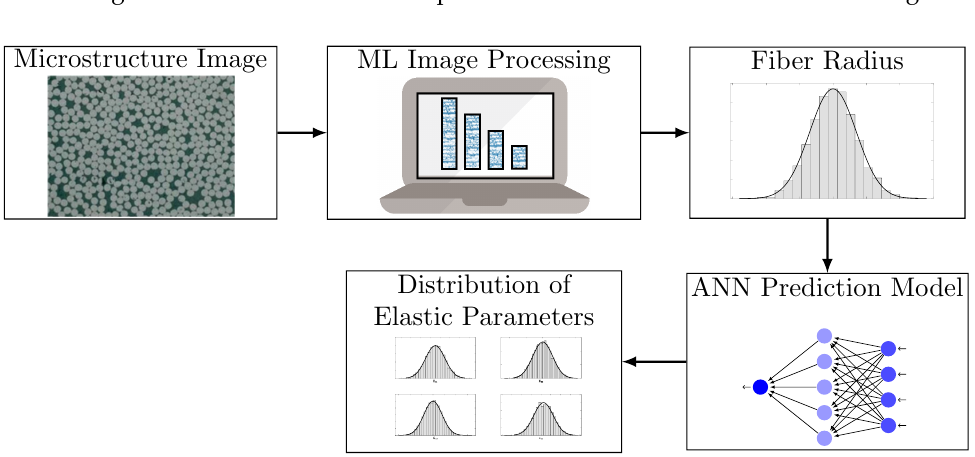
Figure 3. DL based prediction model for estimating the elastic parameters of the composite.